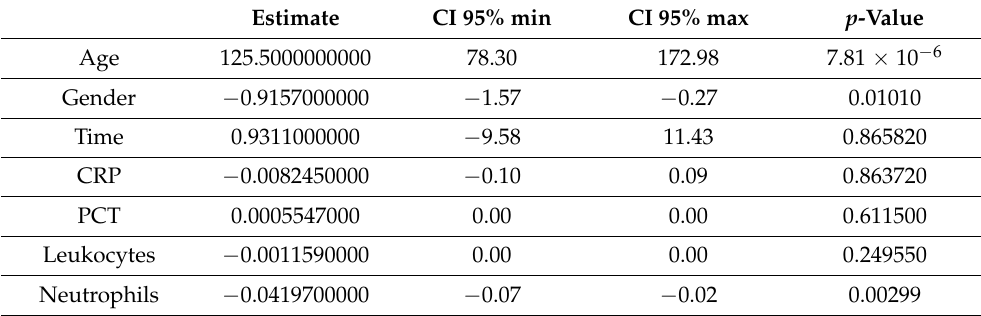
Table 5. Generalised linear mixed models (GLMM) for evaluating the association between biomarkers and creatinine clearance over time in patients without